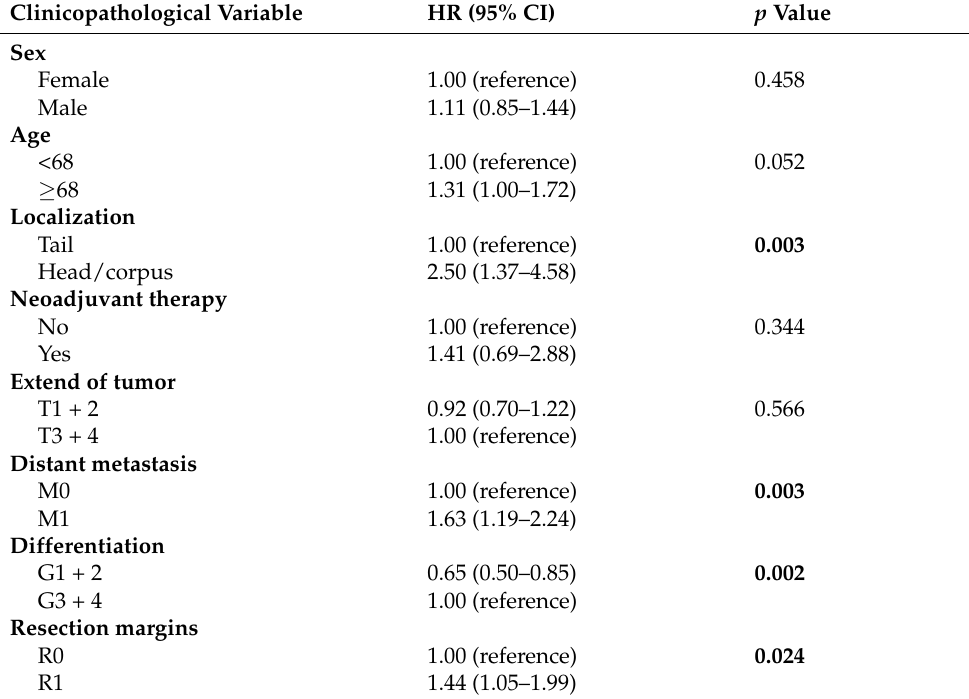
Table 2. Cox regression analysis of the variables considered for the multi-variable adjusted base model.